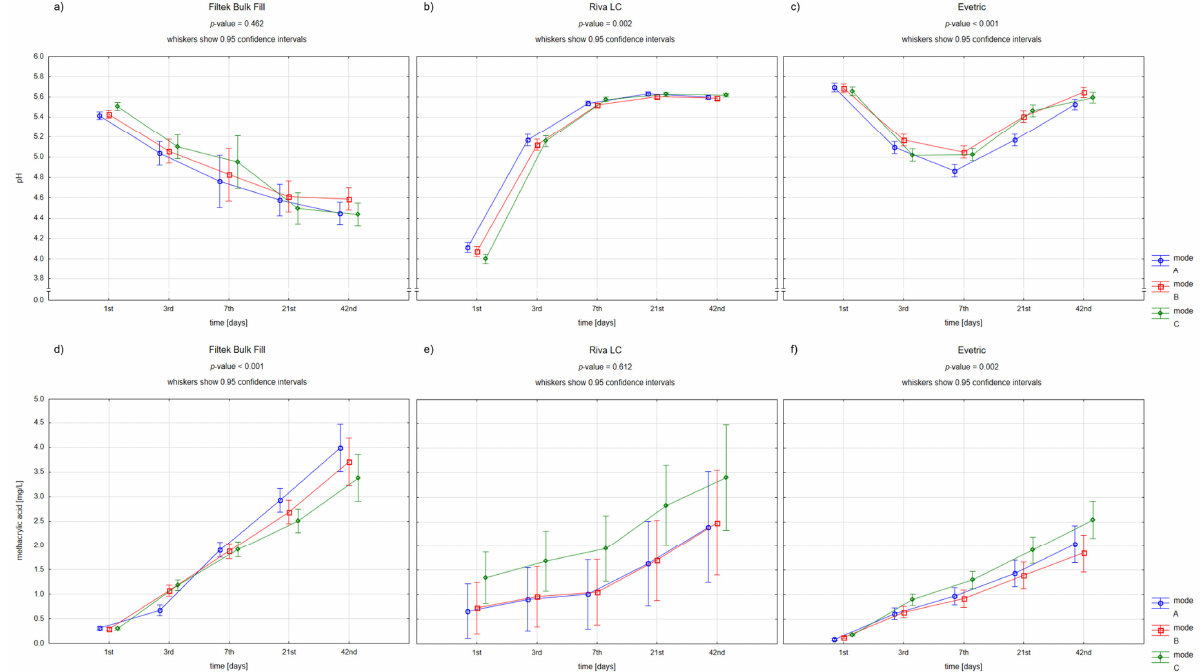
Figure 1. Repeated-measures analysis of variance for pH values ( a – c ) and methacrylate concentrations ( d – f ) in the individual timepoints for the used dental restorative materials depending on the polymerization mode (A-full power mode, B-ramping mode, C-pulse mode).